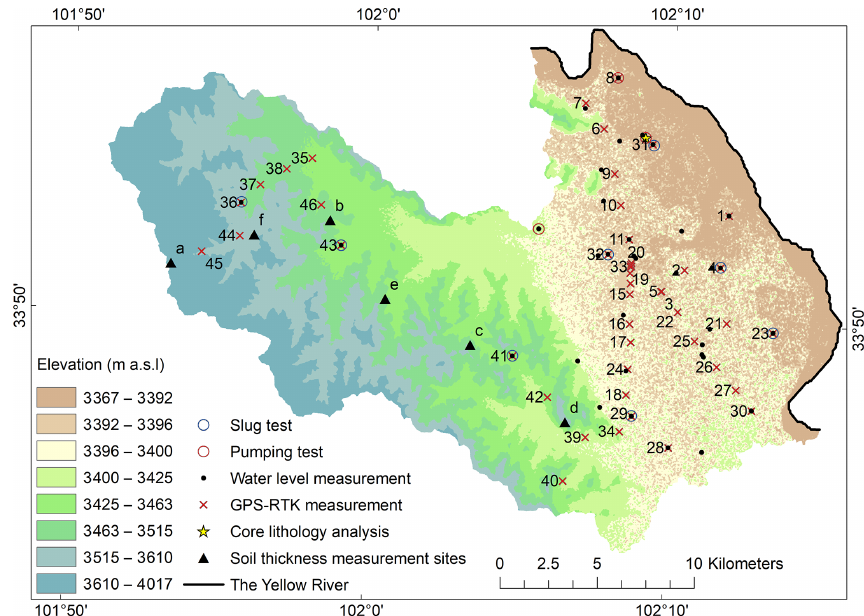
Figure 3. Locations of the hydrogeological surveys, ground surface elevation measurements, core lithology analysis, and soil thickness measurements. The numbers from 1 to 46 (due to limited space, several numbers are not shown in the figure) indicate the measurement sequence of GPS-RTK.